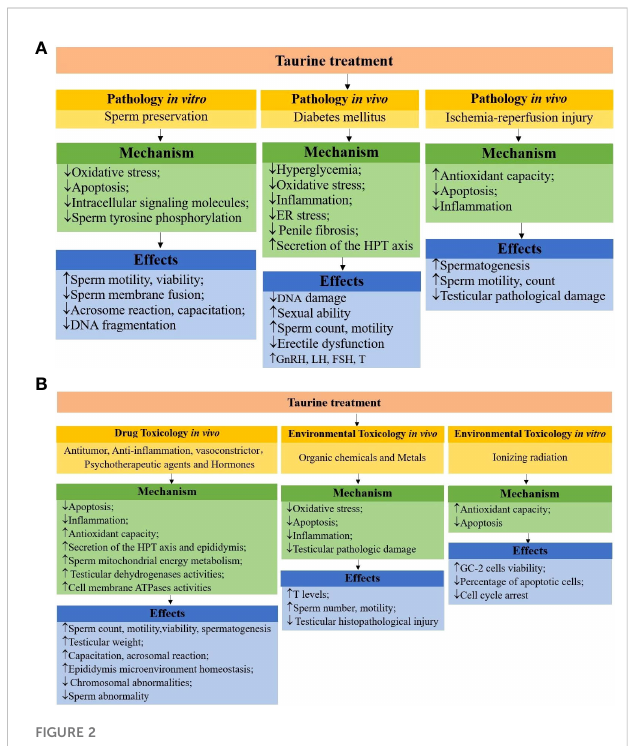
FIGURE 2 (A) schematic mechanisms of taurine protecting male reproductive function in pathologies. (B) schematic mechanisms of taurine protecting male reproductive function in